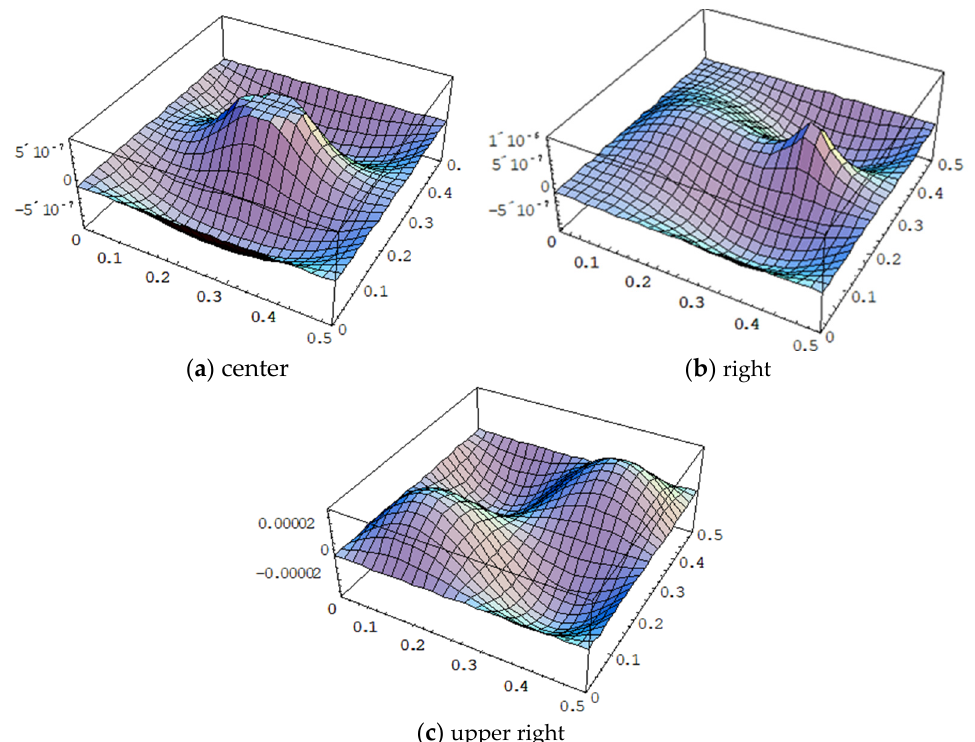
Figure 9. Vibrational amplitude (unit: mm) of the composite laminate plate excited by a PZT actuator bonded to three different locations.